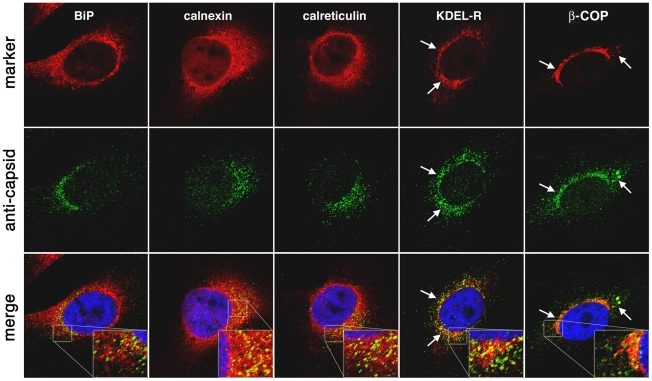
AAV capsids traffic to locations near Golgi/ER transport components.AAV2 virions (10,000 vg/cell) were administered to HeLa cells for 16 hr and prepped for confocal immunofluorescence with antibodies directed toward cellular markers (red) for ER-resident chaperones (BiP, calnexin, calreticulin), Golgi sorting components (KDEL-R,β-COP), or AAV2 capsids (green). Nuclei (blue) were stained with DAPI. White arrows indicate partial colocalization with KDEL-R and β-COP, yet it is difficult to assess whether colocalization occurs with ER markers.